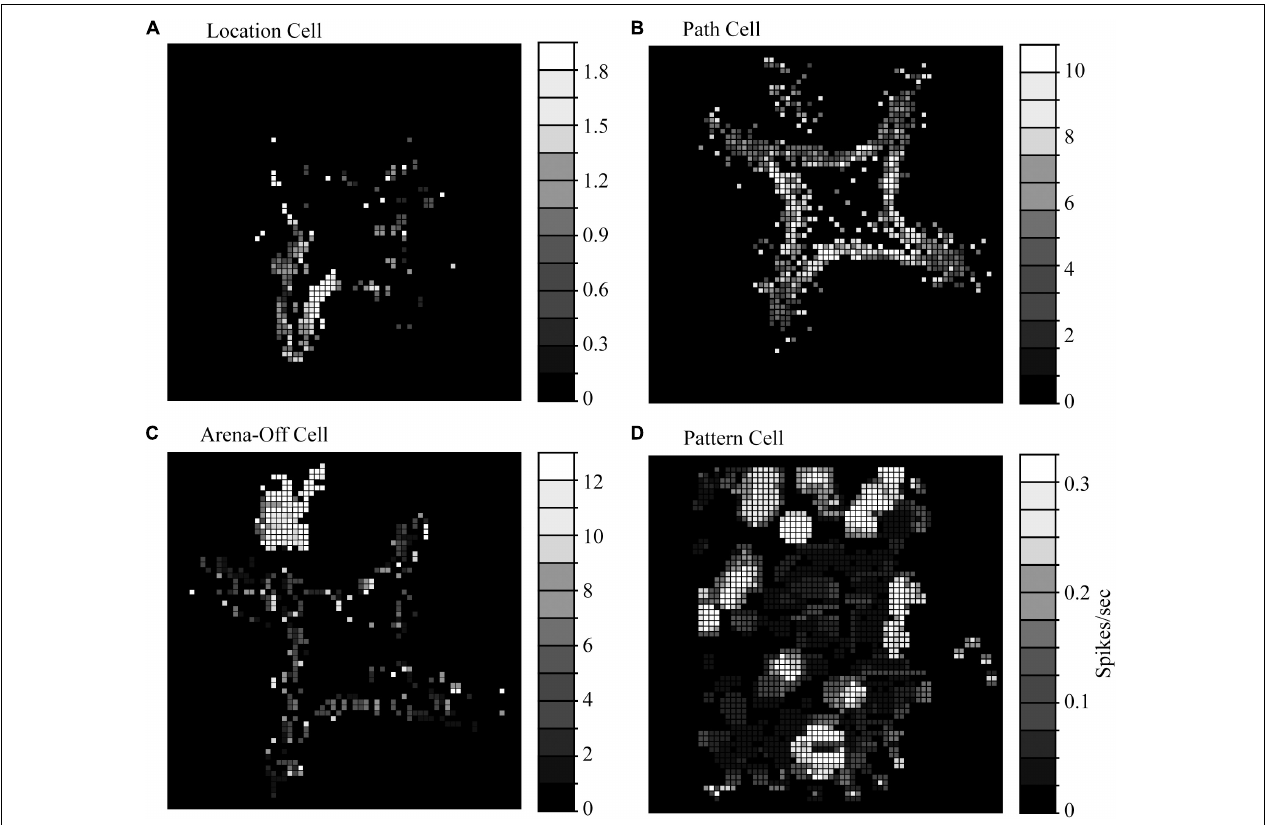
FIGURE 3 | Representative response profiles seen in the homing pigeon hippocampal formation. (A) Path cells have a characteristic high firing rate when the animal is traversing between goal locations (red boxes) but less response at goal locations (blue boxes). (B) Location cells have their highest firing rates when in a localized area near food bowls. The pattern pictured corresponded to a place-like cell. (C) Arena-off cells are presumably context-dependent and fire while in the holding area (in this arena, in the NW corner) but have reduced firing while exploring the arena. (D) Pattern cells have multiple regions of high firing in multiple areas of an open arena that appear to be clustered around the arena edges. (A–C) Adapted from raw data included in Hough and Bingman (2004); (D) adapted from Figure 6A in Kahn et al. (2008) with permission from